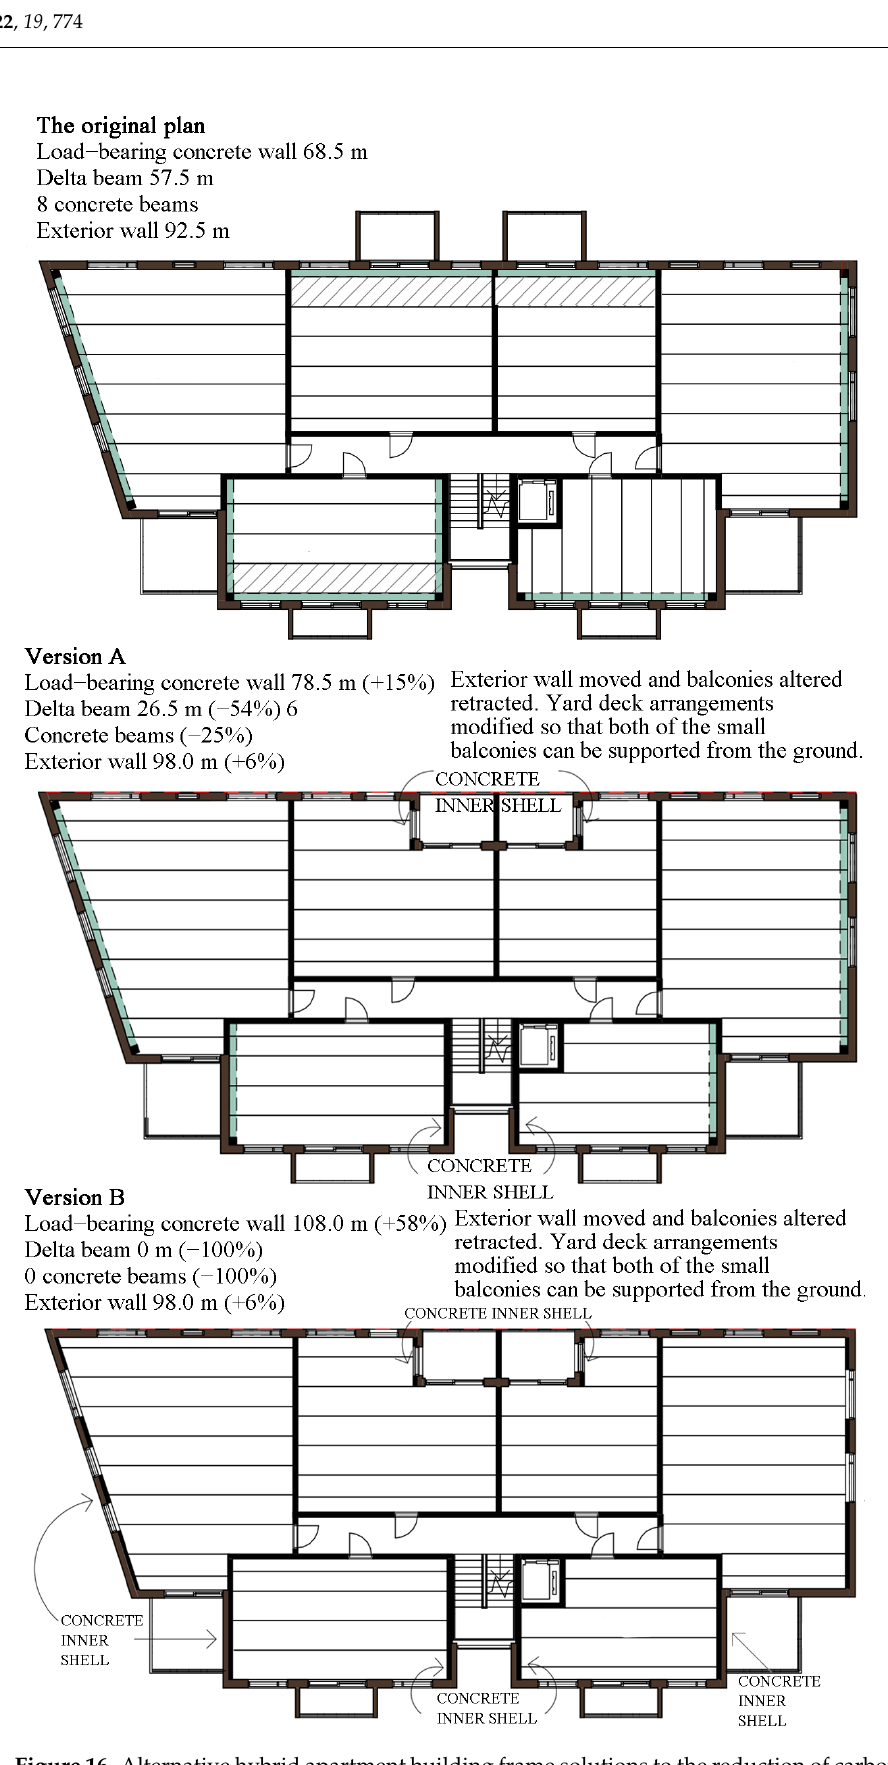
Figure 16. Alternative hybrid apartment building frame solutions to the reduction of carbon foot- print.